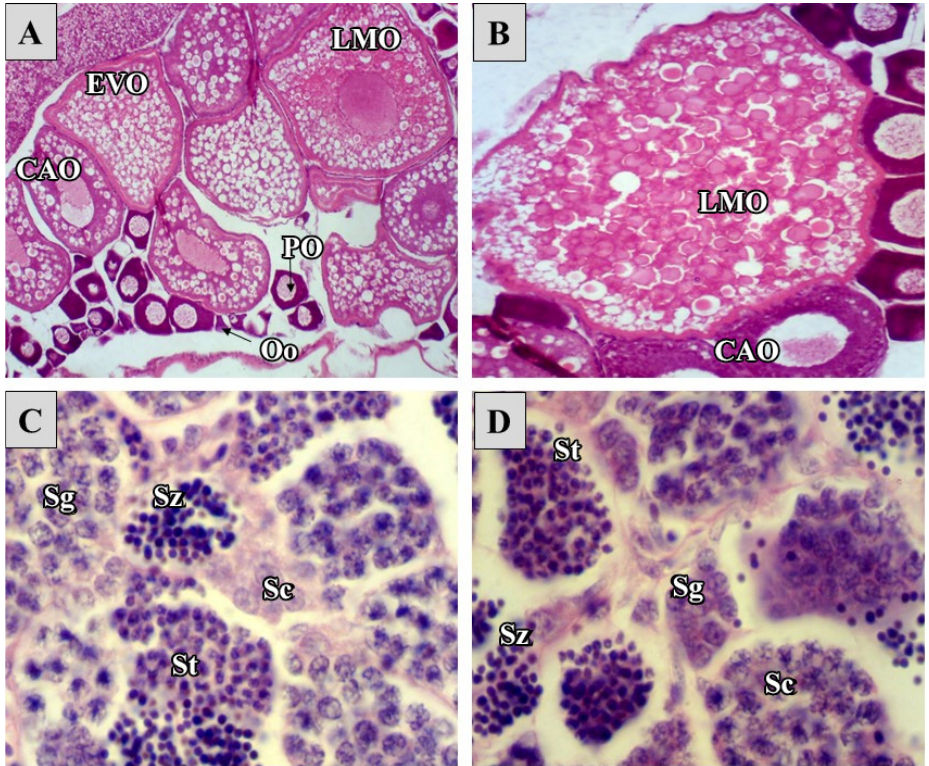
Figure 4. Representative pictures from the animals’ gonads. Top : ovary; bottom : testes. Oogonium (Oo), perinucleolar oocyte (PO), cortical alveolar oocyte (CAO), early vitellogenic oocyte (EVO), late mature oocytes (LMO). Spermatogonium (Sg), spermatocyte (Sc), spermatid (Dt), spermatozoon (Sz). ( A , C ) Representative picture from the untreated group and control groups (2% DMSO); ( B , D ) treated with Ormona ® SI (OSI) or Ormona ® RC (ORC) (200 mg/kg). H&E, 40×. It was observed that the treatment with OSI and ORC increased the percentage of Pharmaceuticals 2022 , 15 , 1434 early-stage reproductive cells whilst decreasing the percentage of mature reproductive cells in female and male animals. In females, the percentage of cortical alveoli oocytes was statistically higher in OSI-treated animals, while the percentage of early vitellogenic oo- cytes and late mature oocytes was lower in female animals. For ORC-treated animals, only the frequency of late mature oocytes was affected (Figure 5). In males, OSI-treated animals had an increased percentage of spermatogonia and de- creased percentage of spermatozoa. Again, ORC did not affect the frequency of early- stage reproductive cells, but the frequency of spermatozoa decreased substantially (Figure 6).